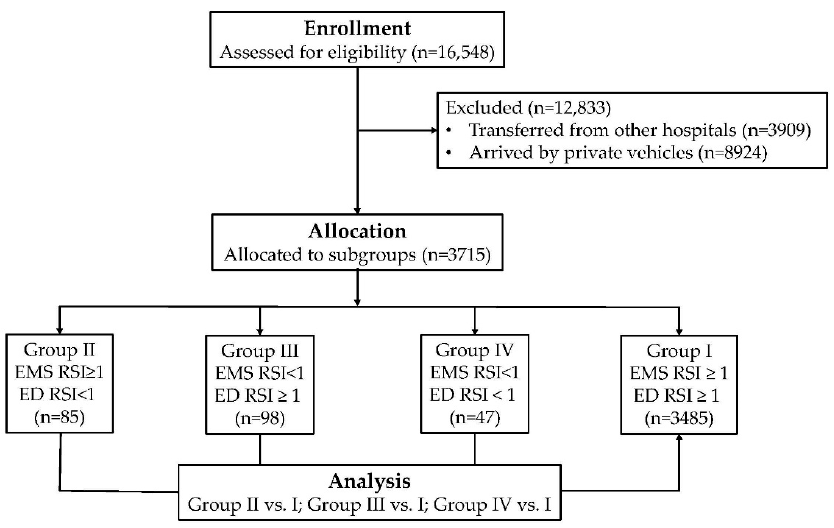
Figure 1. Flow diagram of studied groups of patients.